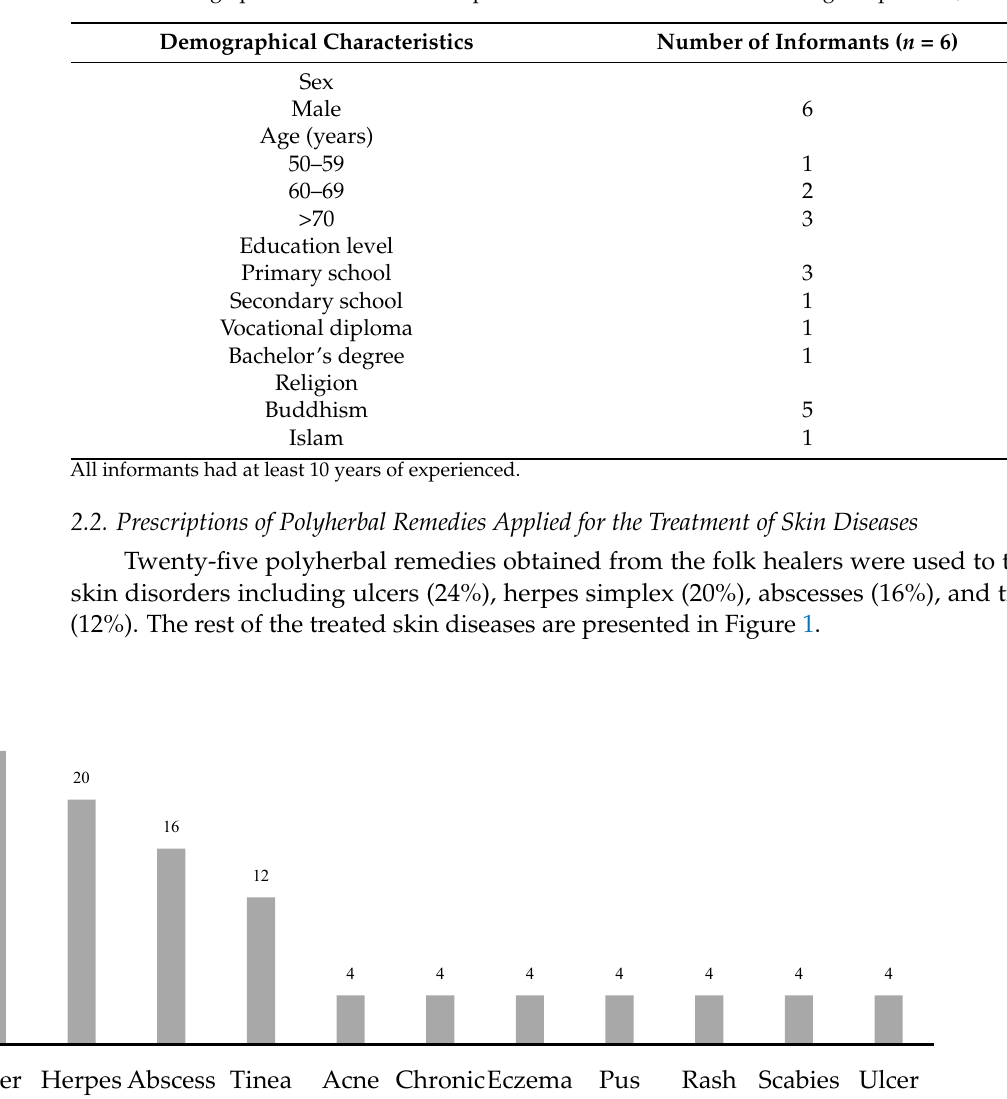
Table 1. Demographical characteristics of experienced traditional healers in the Songkhla province, Thailand.